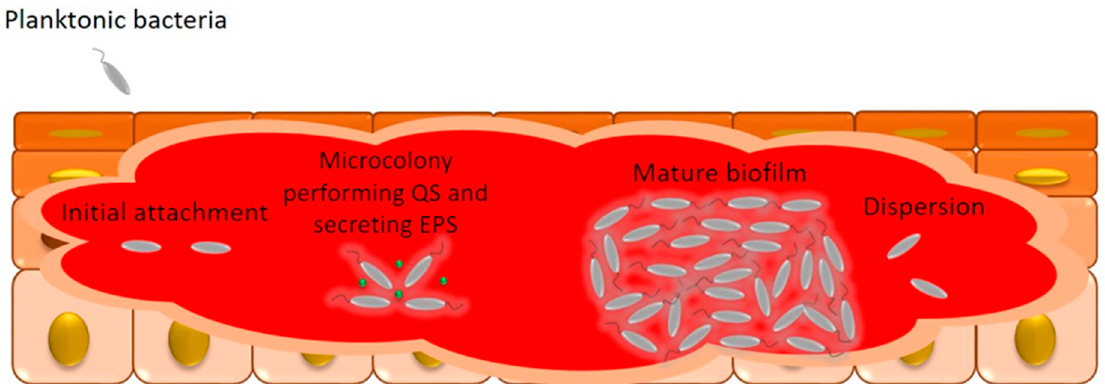
Figure 3. Biofilm formation in wound. Planktonic microbial cells adhere to the wound and form microcolonies in which bacteria begin to secrete molecules to communicate with each other, that is, they perform quorum sensing (QS) as well as secrete extracellular polymeric substance (EPS) in which microbial cells are imbibed until they develop in mature biofilms where microorganisms from the biofilm can detach to infect new